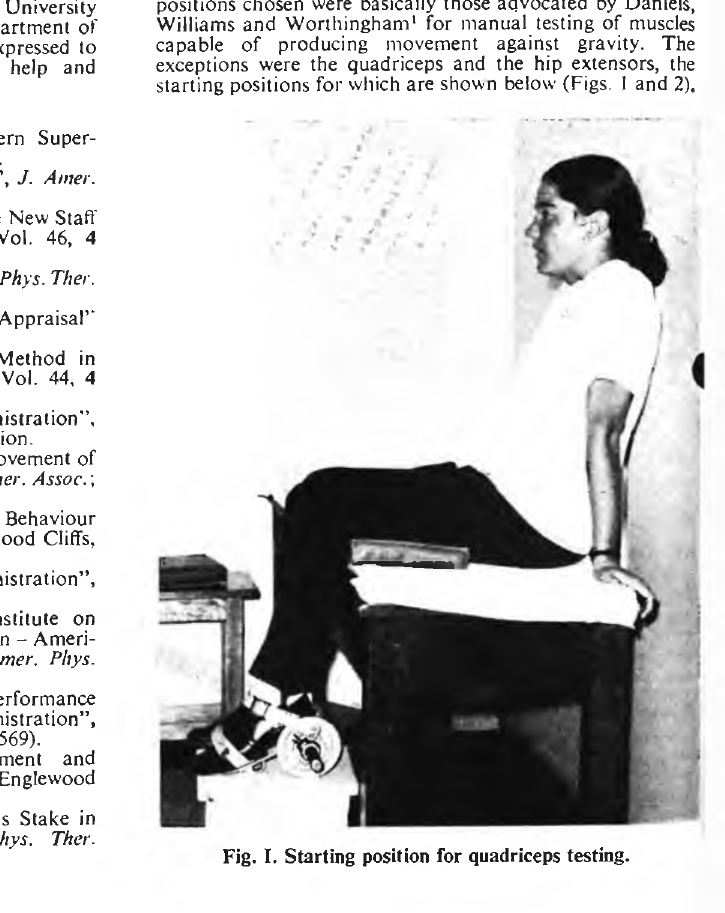
Fig. I. Starting position for quadriceps